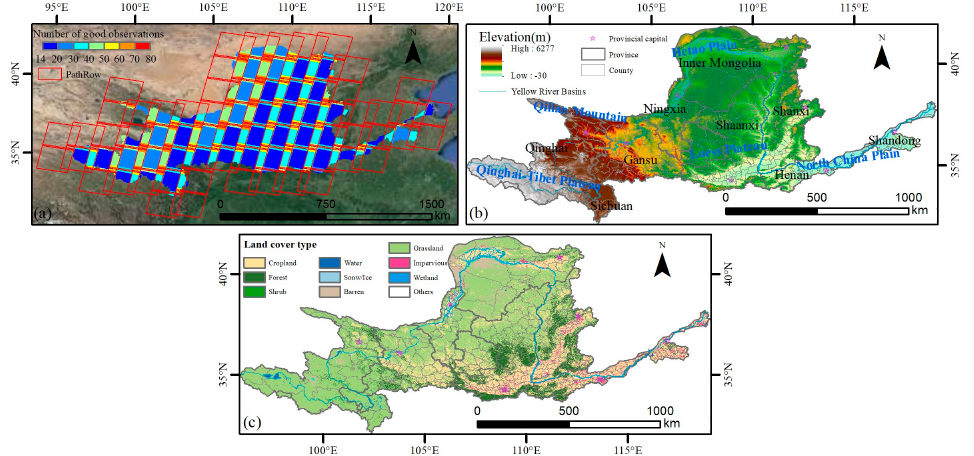
Figure 1. Spatial distribution of the number of high-quality observations in a single pixel of Land- sat5/7/8 image ( a ), Topographic map ( b ) and land cover type ( c ) of the study area.